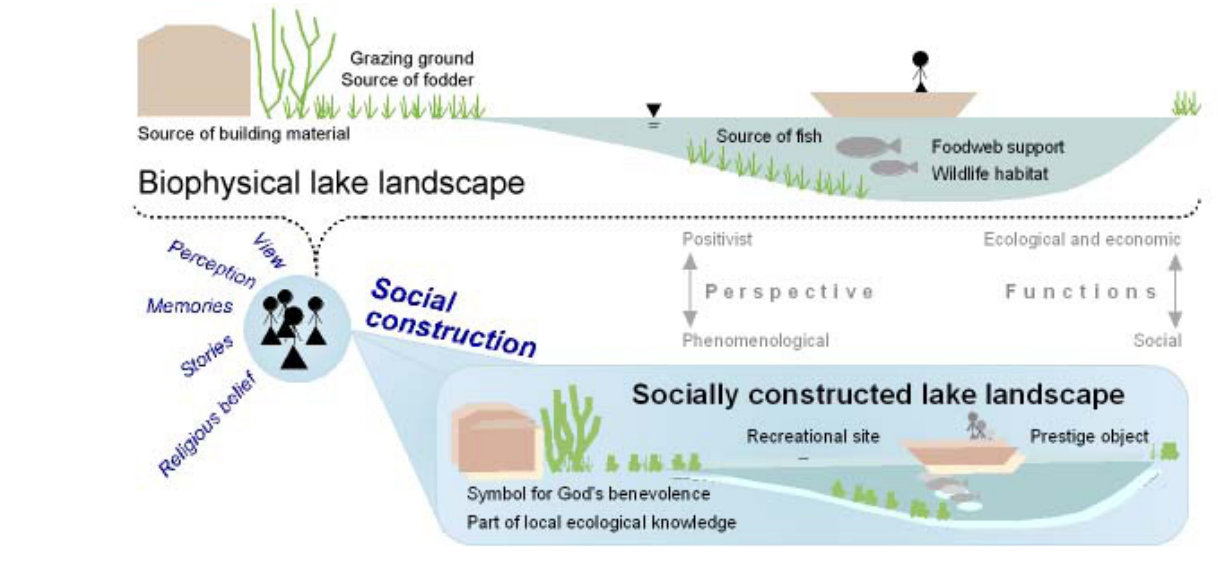
Fig. 3 . Ecosystem services and social functions fulfilled by the biophysical and the socially constructed lake